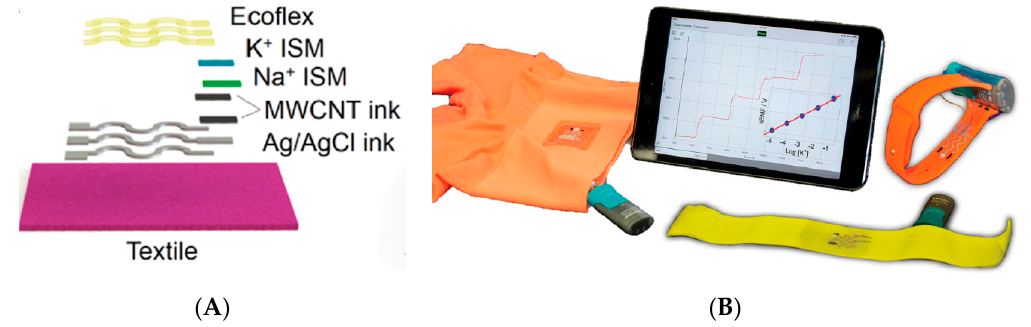
Figure 18. ( A ) Scheme of the manufacturing process on a polyurethane (PU) substrate. ( B ) Examples of use of the sensor, on underwear, wristband, and headband, illustrating the versatility of the printable and stretchable sensor array on different common wearable objects. The tablet displays a real-time trace of increasing potassium levels obtained wirelessly by the underwear printed sensor.